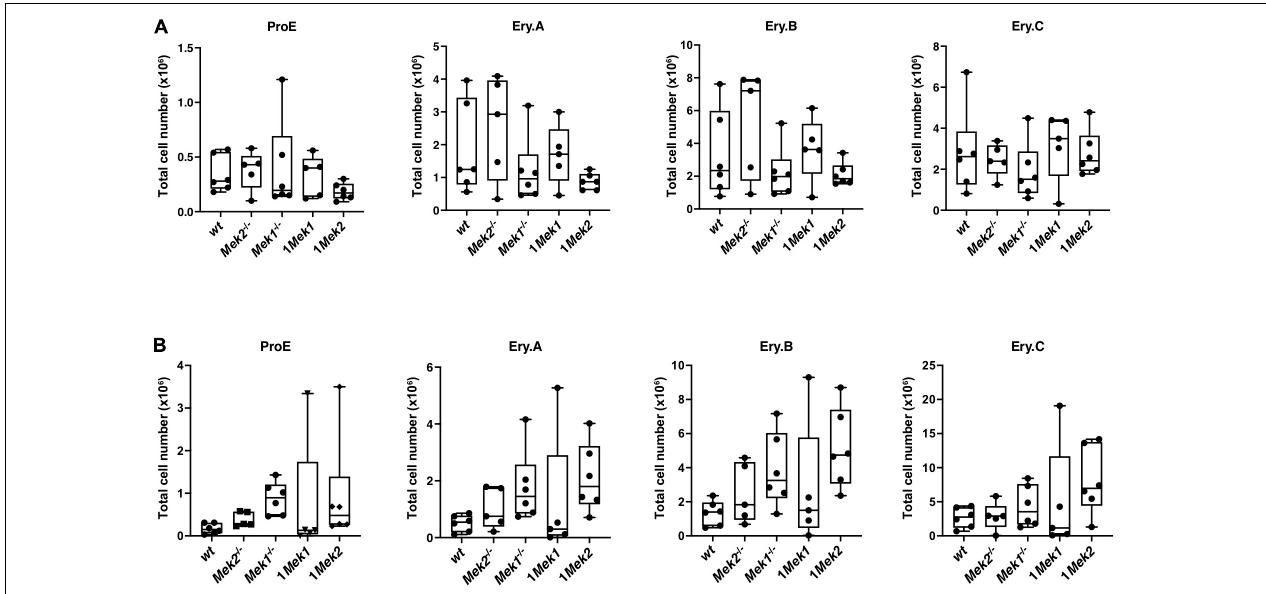
FIGURE 8 | Erythroid subsets in bone marrow and spleen of adult Mek mutants. Erythroid subset analysis by flow cytometry on bone marrow (A) and spleen (B) from wt and Mek mutant adults. Frequency of Ter119 med CD71 high FSC high (ProE), Ter119 high CD71 high FSC high (Ery.A), Ter119 high CD71 high FSC low (Ery.B), and Ter119 high CD71 low FSC low (Ery.C) are presented. The results are presented as whiskers-and-boxes graph, and each dot represents an individual mouse. ANOVA with Tukey multiple-comparisons test was performed. No significant difference was